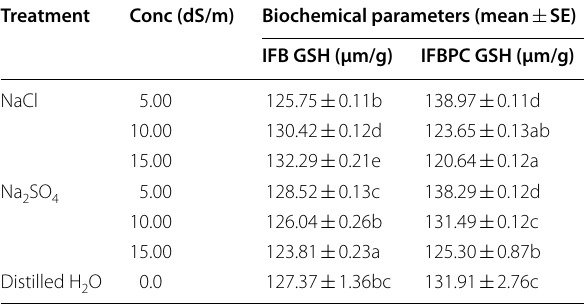
Means followed by different letters in the column are significantly different ( P < 0.05) from one another using Duncan’s new multiple range test (DNMRT)